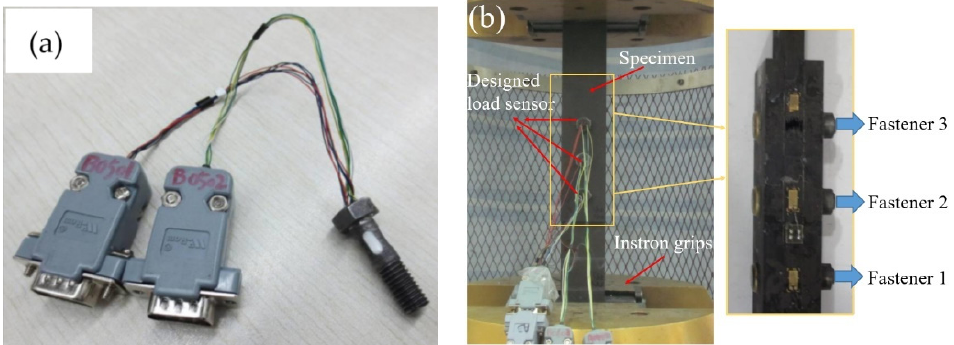
Figure 5. Pictures of ( a ) a specifically designed load sensor for the measurement of pin-load and ( b ) the test set-up.